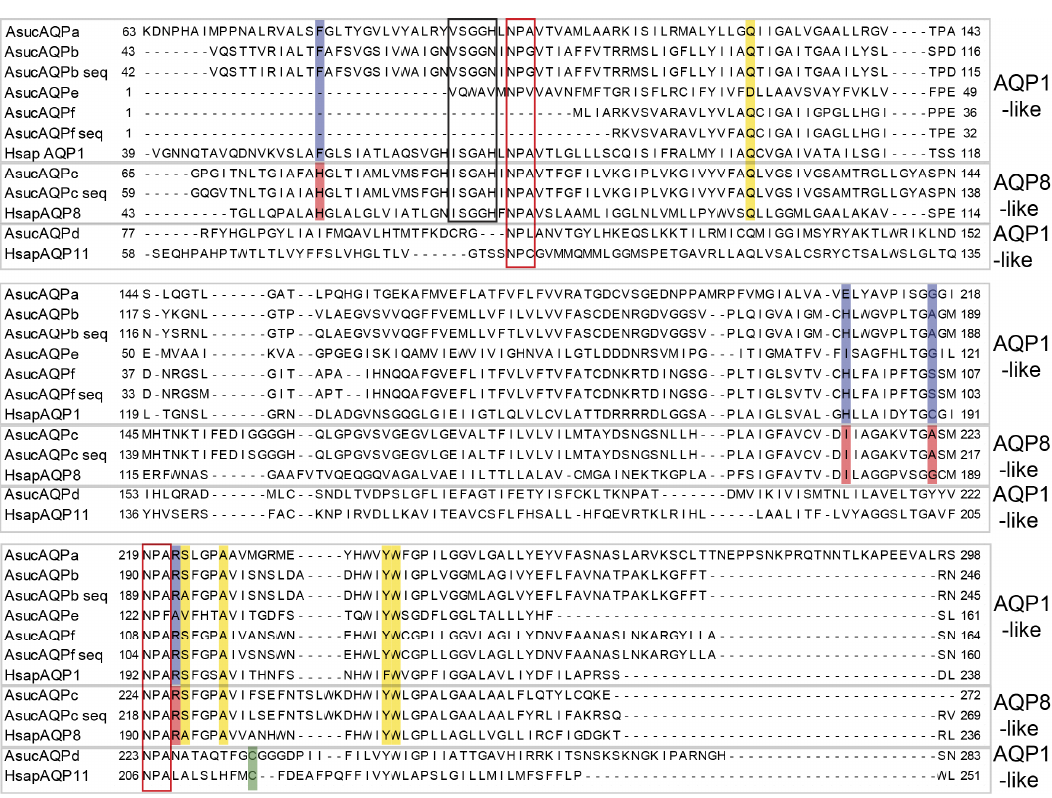
Figure 4. Multiple alignment of the Alitta succinea Aqps (Table 1) and human (Hsap) AQP1 (P29972), AQP8 (XP_011544124.1) and AQP11 (Q8NBQ7). The “seq” suffix marks sequences obtained by RT-PCR, cloning and sequencing. In red boxes the two NPA motifs. The black box indicates the ISSGH motif, typical of the AQP1-like clade. The ar/R regions of both AQP1-like and AQP8-like clades are shaded in blue and red, respectively. The Cys residue down in the C-terminus NPA boxes of the AQP11-like clade is shaded in green. Positions P1–P5 of the AQP1-like clade are shaded in yellow.